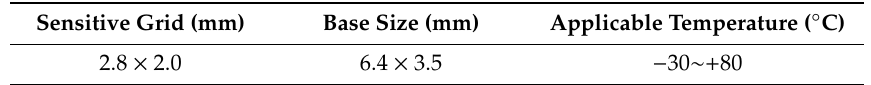
Table 3. Physical specifications of strain